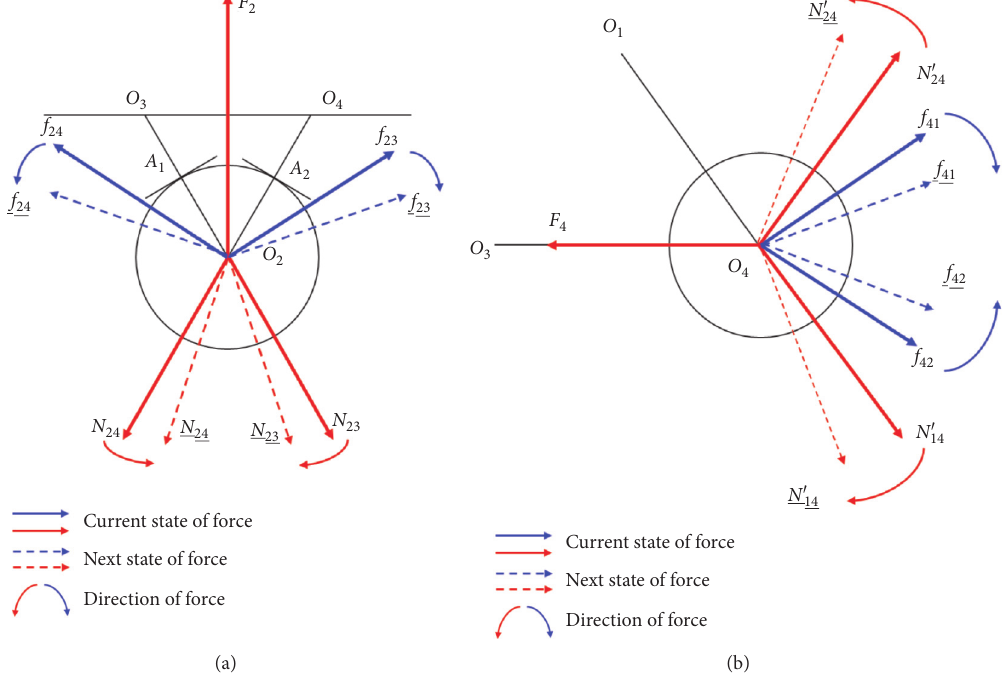
2 . (b) The force analysis